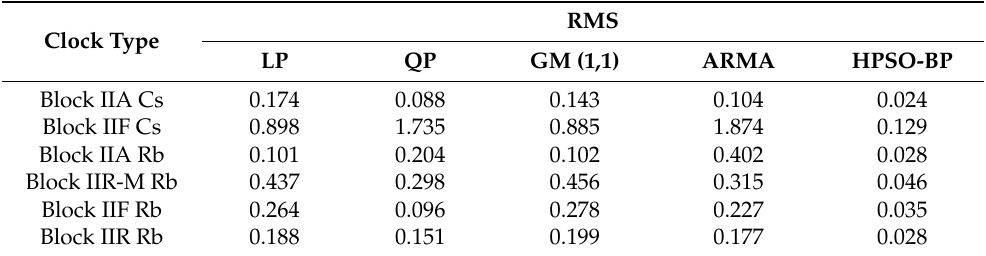
Table 7. Statistics of average prediction results of five models for six different clock types (60-min forecasting) (Unit: